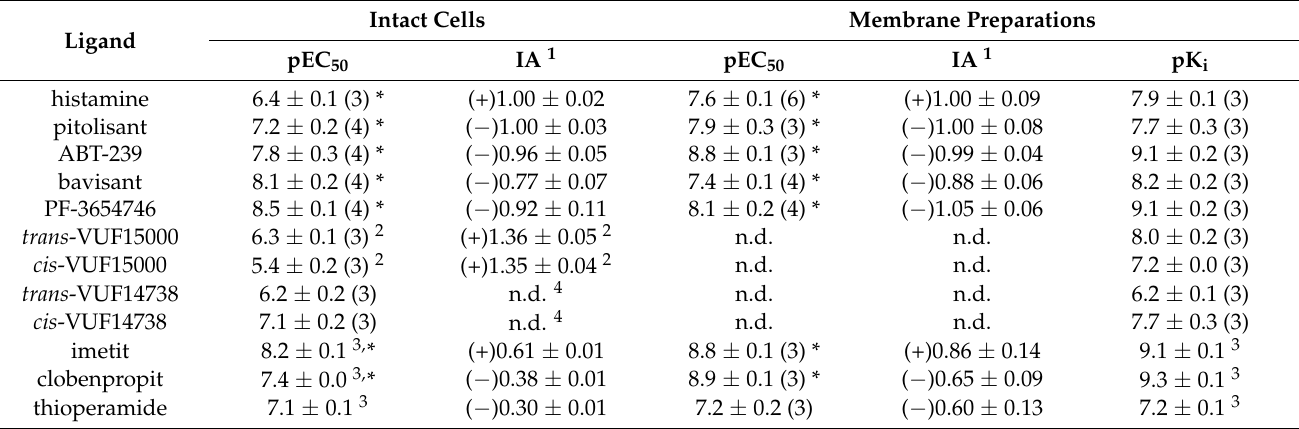
Table 1. Potencies (pEC 50 ), intrinsic activities (IA) and binding affinities (pK i ) of H 3 R ligands on the ∆ icl3-H 3 R Nluc/Halo(618) biosensor expressed on intact cells and membrane preparations, measured in HBSS and 50 mM Tris-HCl (pH 7.4), respectively. The pK i values were calculated using the Cheng–Prusoff equation from the IC 50 values determined in competition binding with [ 3 H]NAMH (Supplementary Figure S1). Data represent the mean ± SD of (n) experiments. n.d.: not